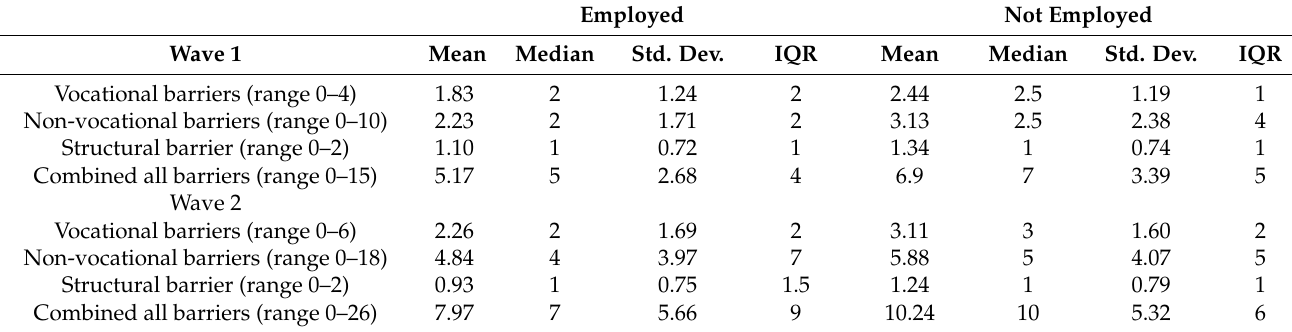
Table 3. Descriptive information for Wave 1 and Wave 2 continuous barriers measures.